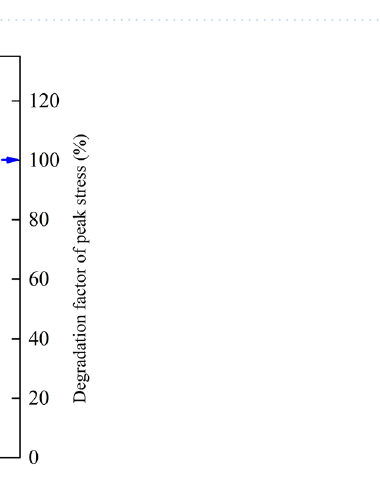
Figure 12. Stress–strain curves of limestone samples after high-temperature treatment: ( a ) 25–600 °C; ( b ) 25–1000 °C.